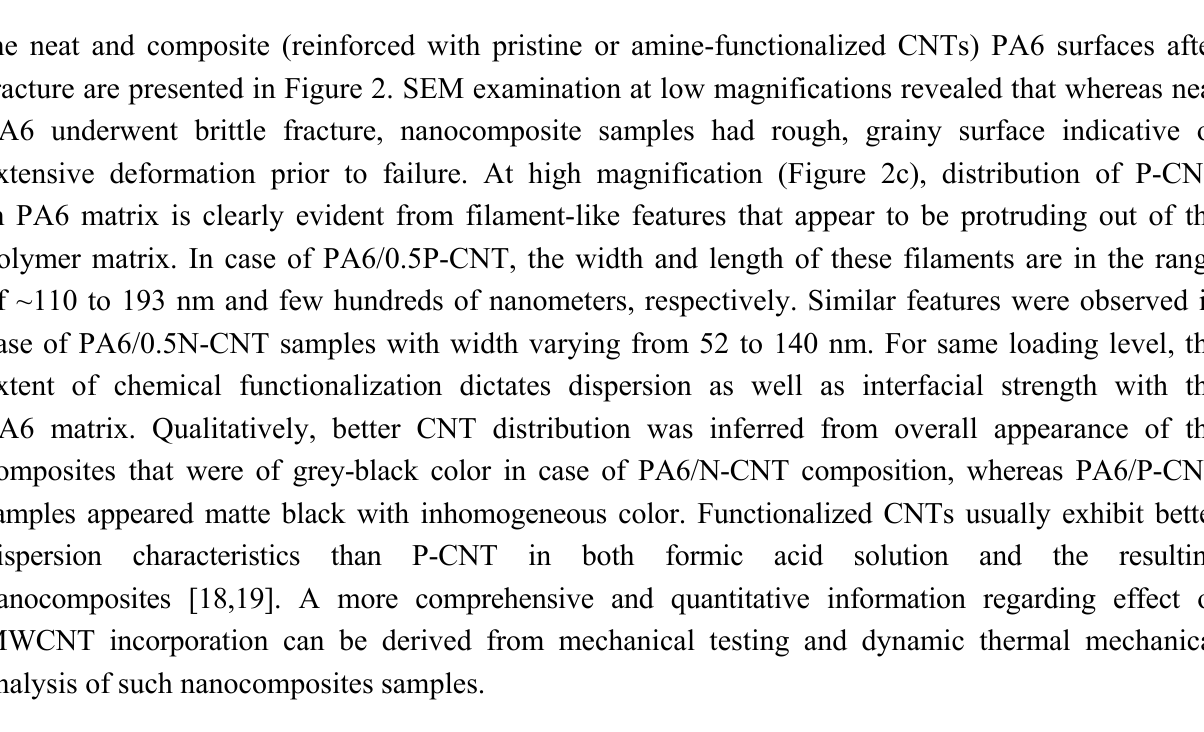
Figure 2. SEM microstrucres of cryogenically fractured surfaces of neat and nanocomposite polyamide 6 (PA6) samples: ( a , b ) neat PA6; ( c ) PA6/0.5P-CNT; and ( d )